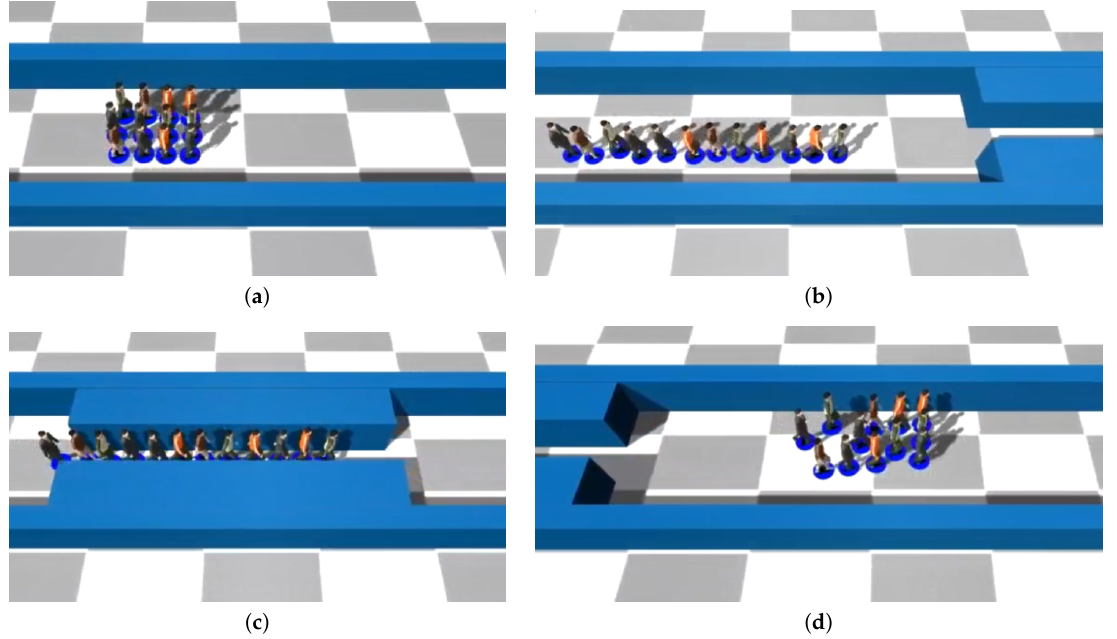
Figure 7. The behavior of a group in front of a narrow space according to Reference [1]: ( a ) Agents in a uniform formation are approaching the corridor. ( b , c ) All of the agents will change their formation to the line shape at the same time for being able to pass through the narrow space. ( d ) They change to their previous formation all together after passing the corridor.